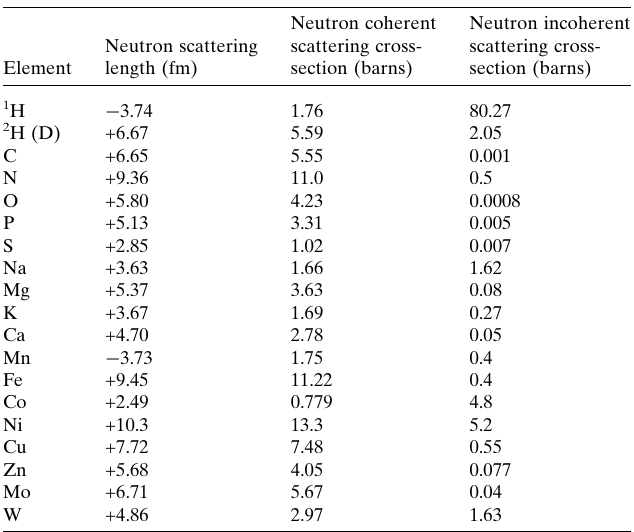
Table 1 Neutron scattering properties of selected elements in biological